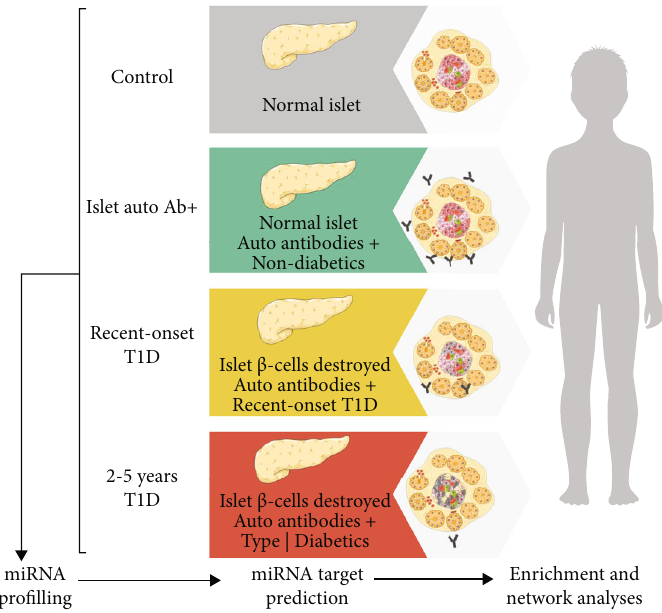
Figure 1: Progression of type 1 diabetes and experimental protocol — Megaplex ™ pool for microRNA Expression Anal-